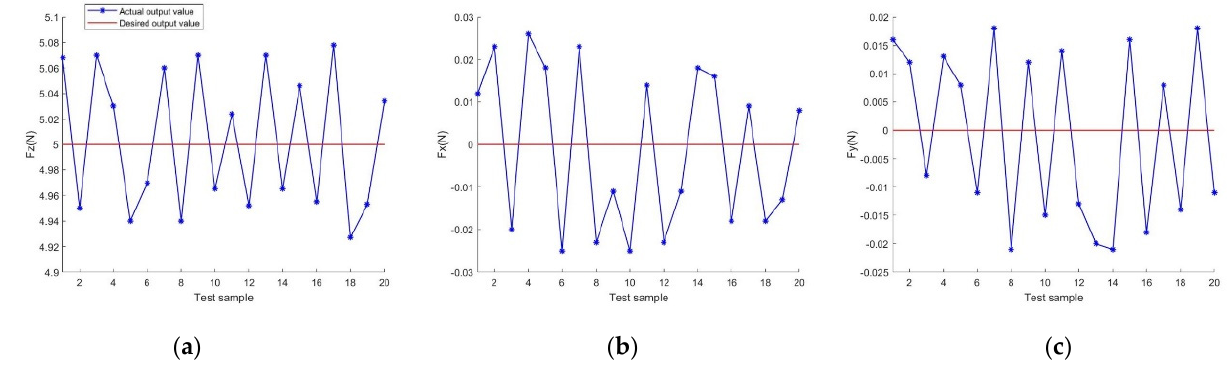
Figure 11. Output values of each channel when 5N load is applied in Fz direction. ( a ) Fz channel output value; ( b ) Fx channel output value; ( c ) Fy channel output value. The measured and predicted values of the sensor are shown in Figure 12 when we applied different forces to the sensor in the X, Y and Z directions, respectively.